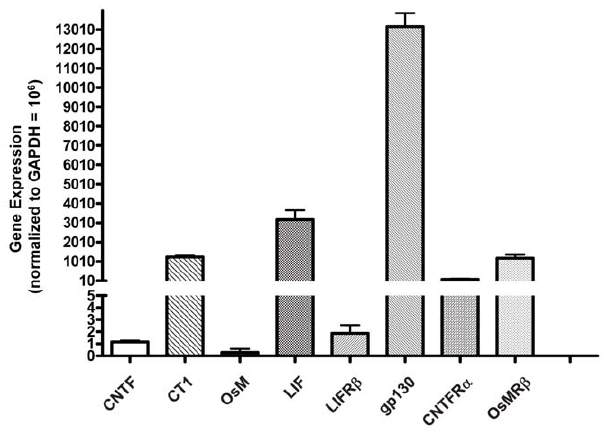
Figure 3. Gene expression of CNTF, CT1, OsM, LIF and their receptors in hfRPE. Relative amounts of messenger RNA were quantified using real time PCR. All data normalized to GAPDH=10 6 . Experiments were performed in triplicate using cells from four different donors.